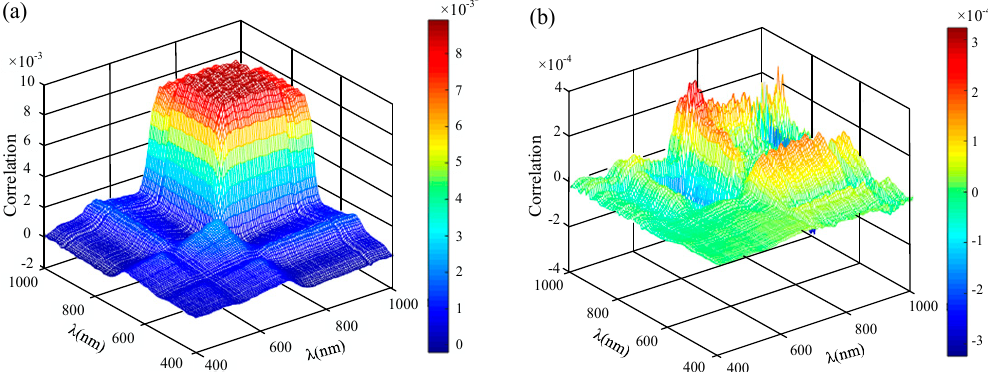
Figure 6. Two-dimensional correlation spectrum of the canopy. (a) Synchronous spectrum, (b) asynchronous spectrum.